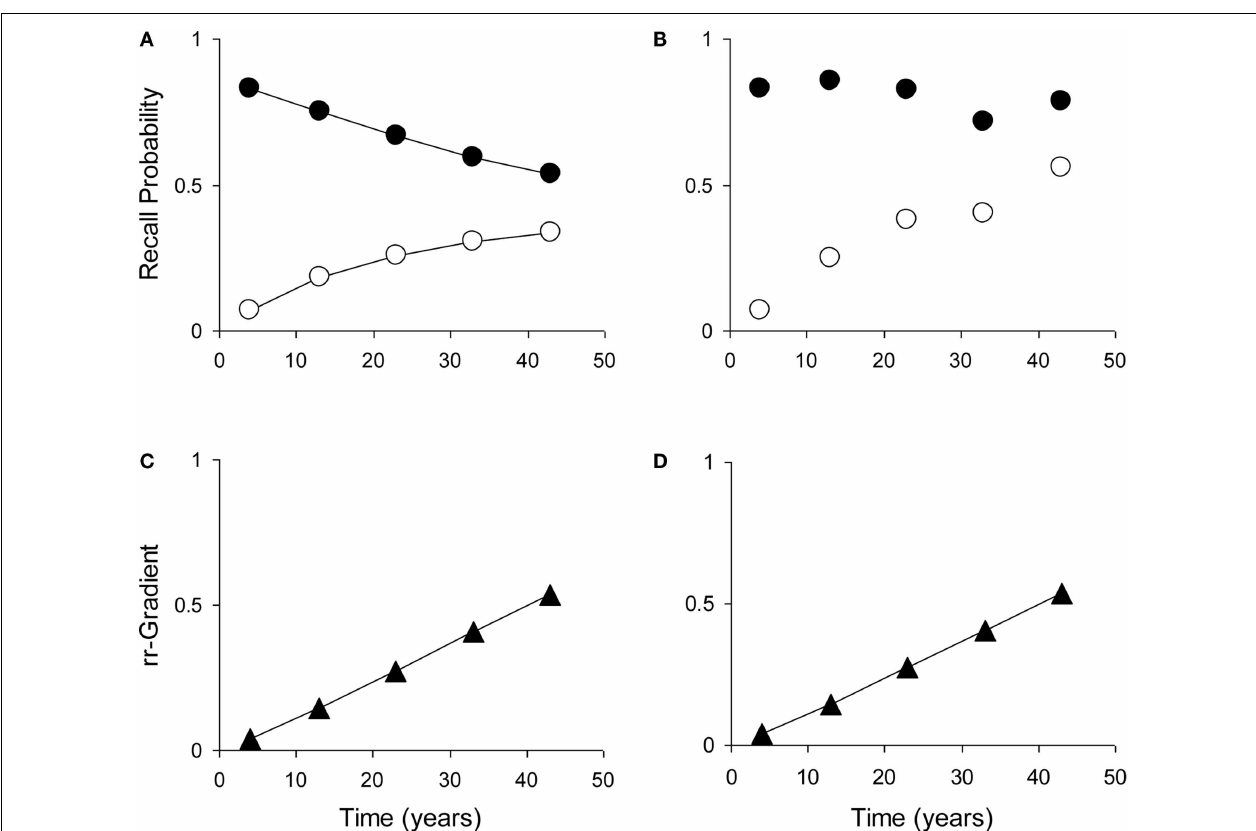
a 2 = 0. (B) Distorted curve where µ 1 has been multiplied with (from left to right) 1, 1.4, 1.8, 1.4, and 2. (C) Relative retrograde gradient for the undistorted curves. (D) Relative retrograde gradient for the distorted